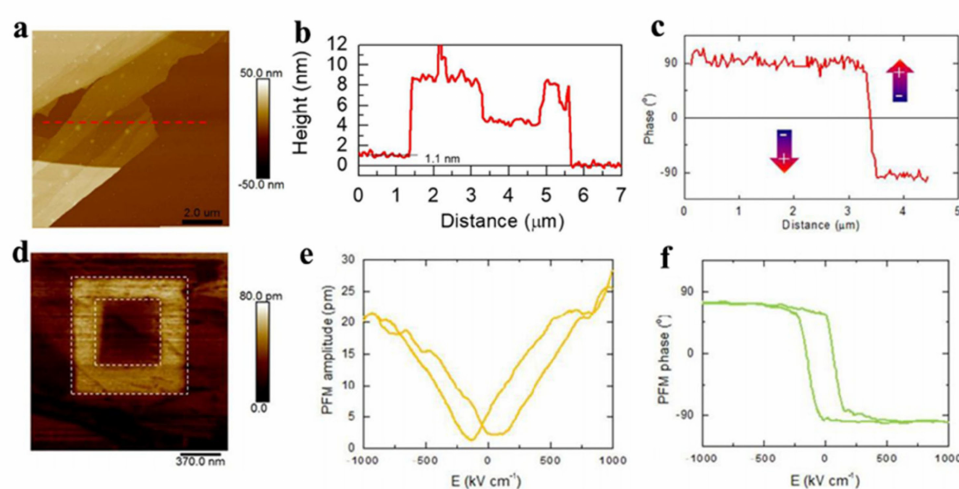
Figure 9. ( a ) AFM topography (10 × 10 µ m 2 ) of exfoliated α –In 2 Se 3 thin layers on SiO 2 /Si substrate; ( b ) corresponding height profiles taken along the red dash line in ( a ); ( c ) the phase profile of different ferroelectric domains; ( d ) PFM amplitude image of domain engineering in α –In 2 Se 3 with film thickness 12 nm; ( e ) PFM phase hysteresis loop measured and ( f ) PFM amplitude from α –In 2 Se 3 thin layers. Adapted with permission from ref. [90], copyright: 2018, Royal Society of